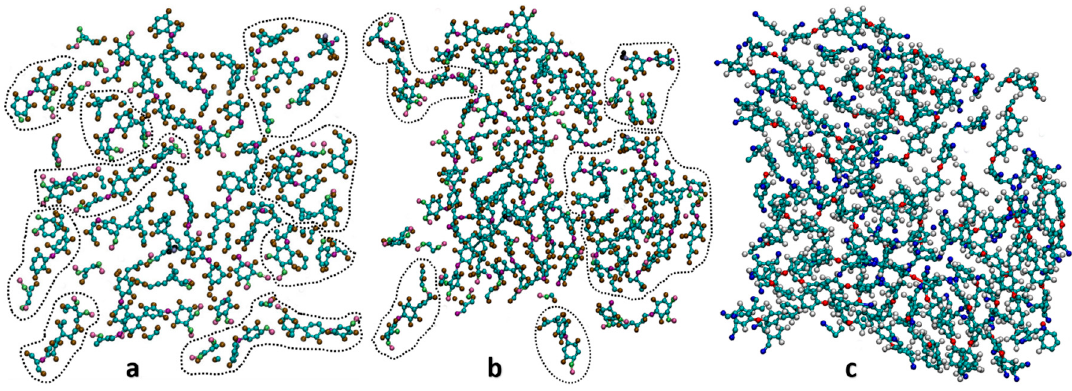
Figure 4. Cross sections of crosslinked phthalonitrile system with ( a ) 25%, ( b ) 50% and ( c ) 100% cross-linking. In ( a , b ), different clusters of polymers that are un-crosslinked are circled by dash lines.